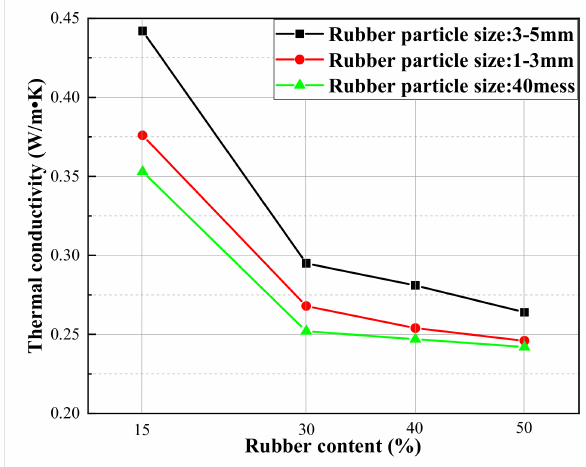
Figure 13. Thermal conductivity of each specimen.